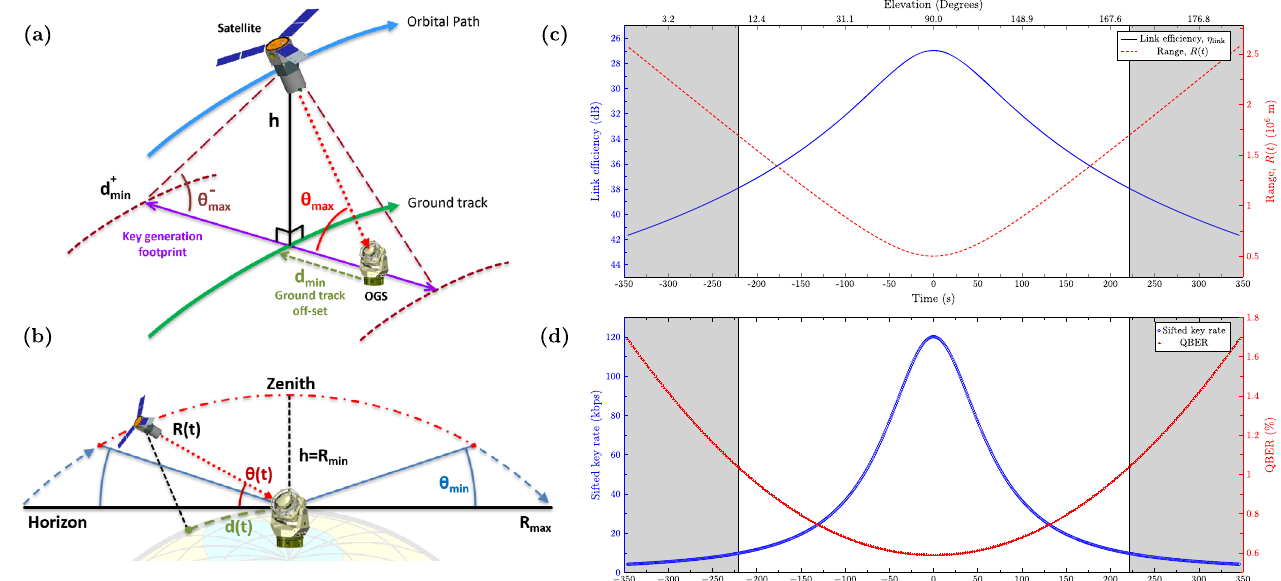
Fig. 1 Satellite-to-ground QKD model. a General satellite overpass geometry for circular orbit of altitude h 50 . Maximum elevation θ max reached when satellite — OGS ground track distance is at a minimum, d min . The smallest θ max , θ (cid:3) . b Zenith overpass maximises transmission time with lowest average channel loss. Quantum transmission is limited generation footprint 2 d þ min to above θ min . c Zenith overpass channel loss vs time/elevation (based on ref. 42 data). Link loss varies with range ( R − 2 diffraction fall-off) and the atmospheric optical depth (attenuation and turbulence). Peak link loss η link at zenith characterises the system loss performance level, denoted η sys . Additional constant losses (independent of range and elevation) are modelled by constant dB offset to the link loss curve, hence loss . d Modelled sifted key rate and QBER vs time/elevation. Zenith overpass, η sys also off-setting η sys loss BB84 WCP-DS protocol parameters: